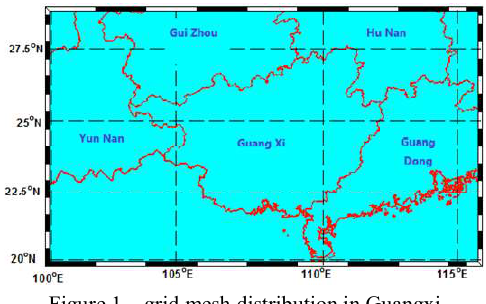
Figure 1 grid mesh distribution in Guangxi